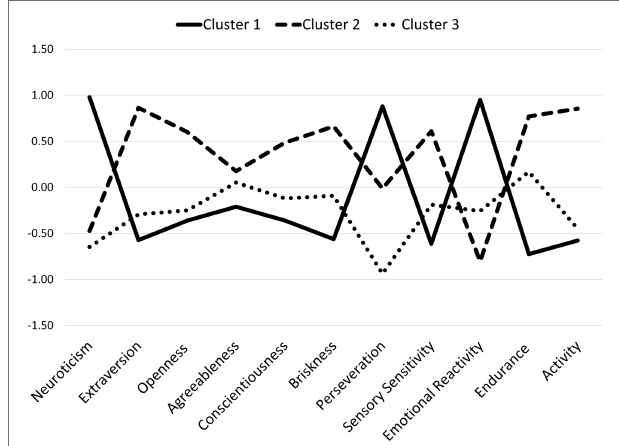
FIGURE 1 | The final cluster centers in the three extracted types of temperamental and personality traits profiles. Cluster 1, higher Neuroticism, Perseveration, and Emotional Reactivity; Cluster 2, higher Extraversion, Briskness, Sensory Sensitivity, Endurance, Activity, and Conscientiousness; Cluster 3, lower